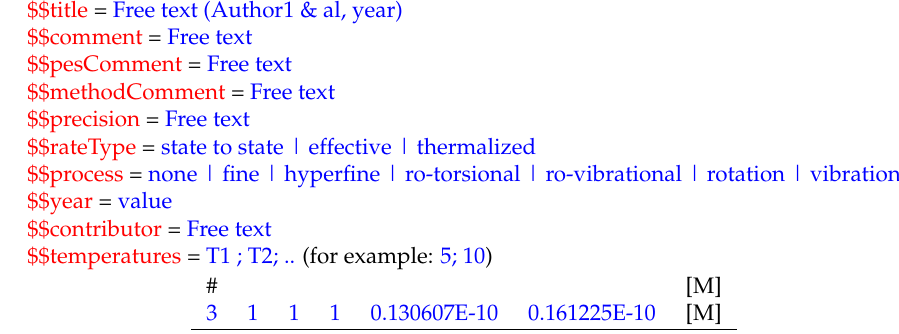
Table A5. Template of a “Fitting coefficients” input as requested by the import script. The metadata are in red and the values in blue. None of the information is requested by VAMDC. The metadata $$designation has the following choices explained in the text (common fit equation | Faure et al. 2004 | Lim et al. 1999 | Faure et al. 2001 | Sarpal et al. 1993 | Not available). In the second part of this entry, the first four columns indicate the energy level’s labels in the same way as as in the rate coefficient table (see Table A4); this is followed by the values of fitting coefficients whose symbols are indicated in the parameter $$coefficients. [M] stands for mandatory. In the current template, the transition is between the third and the first energy levels of the target with the collider in its fundamental state, and the fitting functions have two